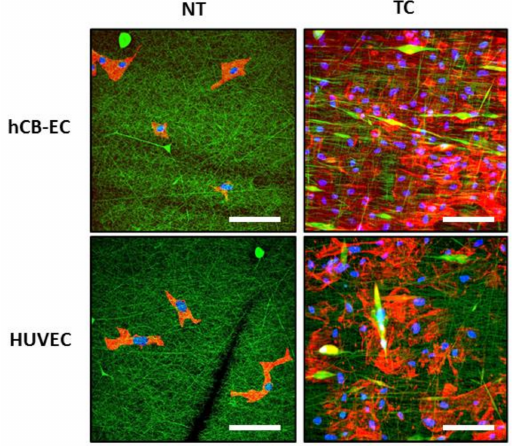
Figure 4. Maximum intensity projection multiphoton images of hCB-ECs or HUVECs cultured in nontreated (NT) or thermoformed/coated (TC) scaffolds after 7 days of culture (green—scaffolds; blue—nuclei; red—F-actin). The combined surface modification of thermoforming and coating favor cell spreading and cell attachment, especially for hCB-ECs. Scale bar = 100 µ